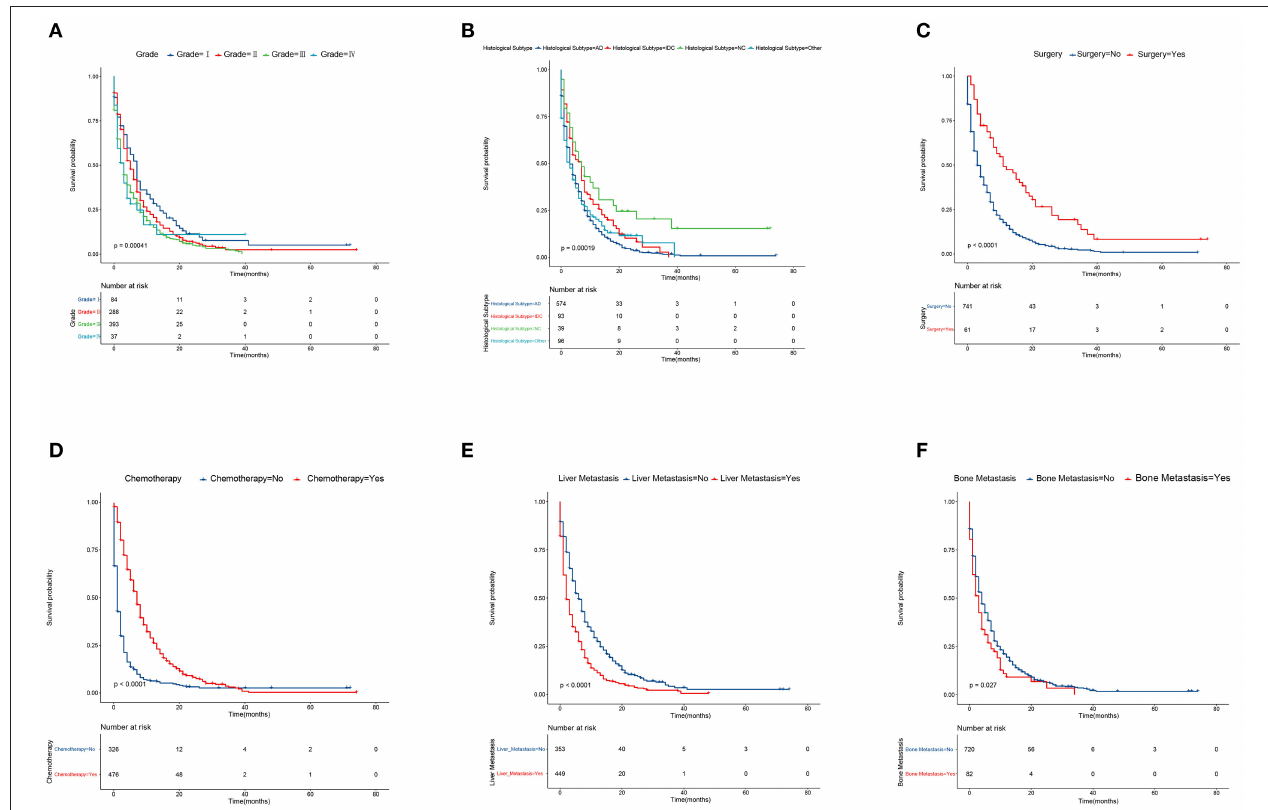
FIGURE 2 | Kaplan–Meier analysis of overall survival among pancreatic cancer patients with lung metastasis at diagnosis. (A) grade, (B) histological subtype, (C) surgery, (D) chemotherapy, (E) liver metastasis, and (F) bone metastasis.